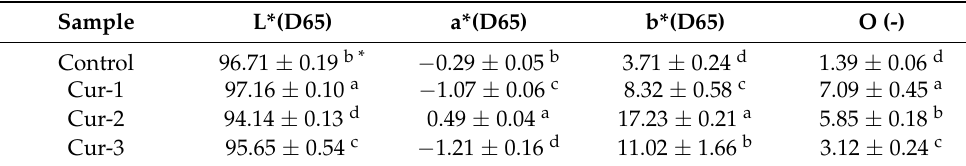
Table 4. Measurement of color and transparency of the control film and the film with curcumin added at different concentrations.